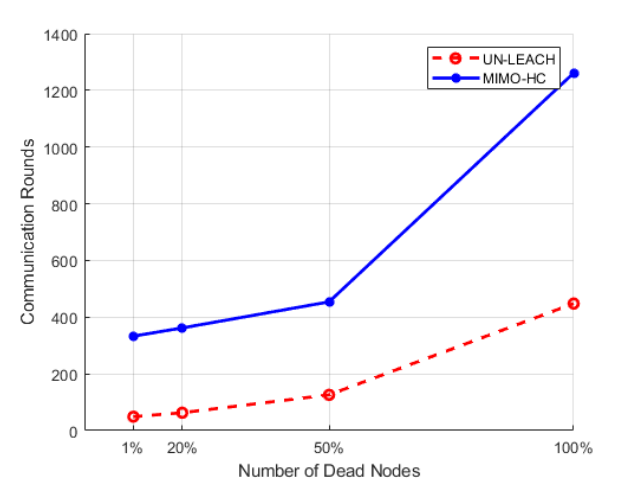
Figure 13. Performance results for 150 nodes in a 200 m × 200 m network.